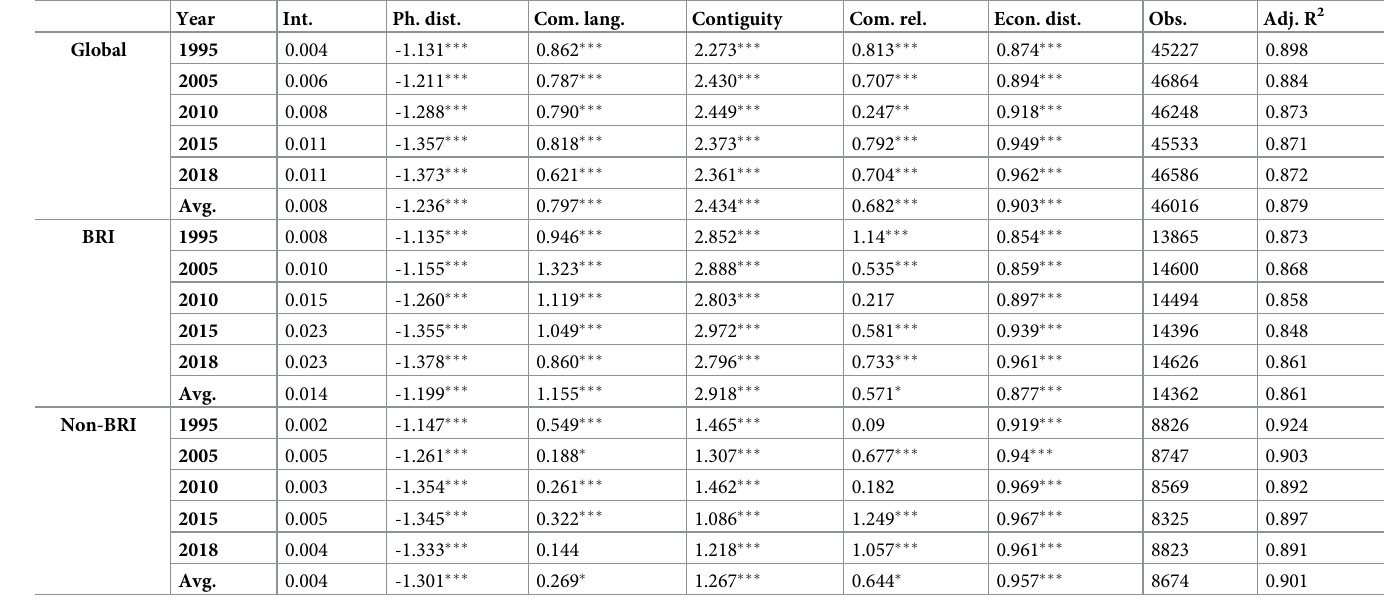
Table 5. QAP regression results for selected years and average over 1995–2018.